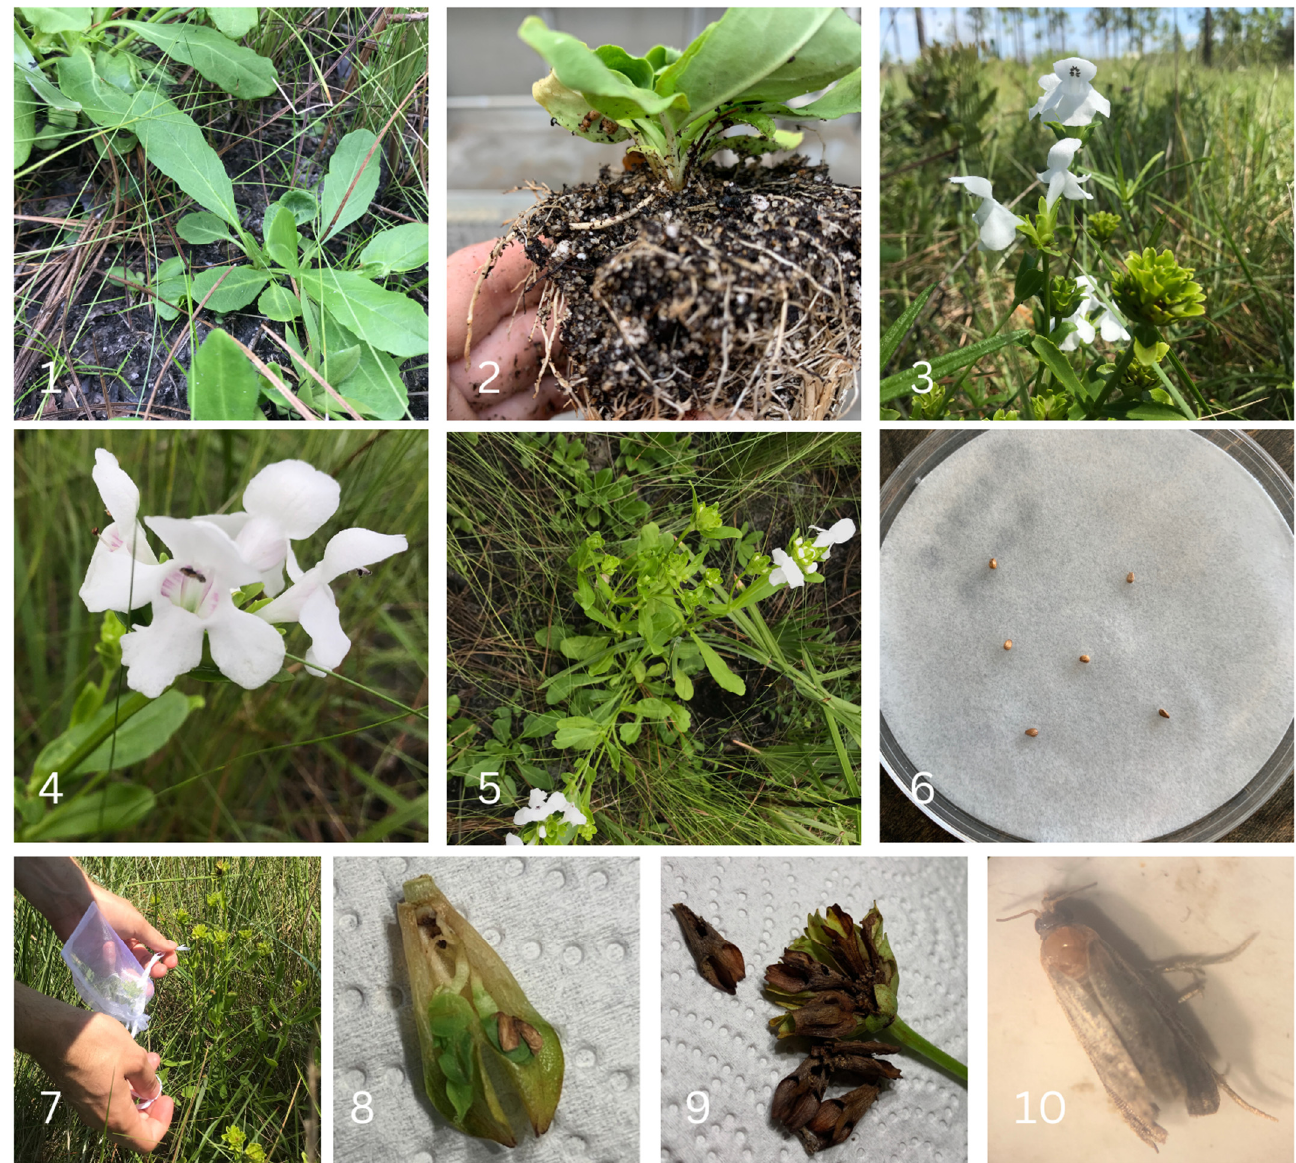
Figure 1. Photos of plant and reproductive parts of Macbridea alba individuals with one or multiple stems per rosette. Photos from left to right: ( 1 ) basal rosettes in situ; ( 2 ) basal rosette and root system of ex situ grown individual; ( 3 ) multi-stemmed inflorescences of single individual (side-profile); ( 4 ) single inflorescence; ( 5 ) multi-stemmed inflorescences of multiple individuals (top-profile), ( 6 ) Macbridea alba seeds in petri dish for germination trial; ( 7 ) bagging single stem of multi-stemmed individual in the field; ( 8 ) multiple pre-germinated seeds within single calyx; ( 9 ) evidence of herbivory on calyces of Macbridea alba infructescence; ( 10 ) specimen of Endothenia hebesana (Walker) or the Verbena Bud Moth discovered in specimen bag during collection.